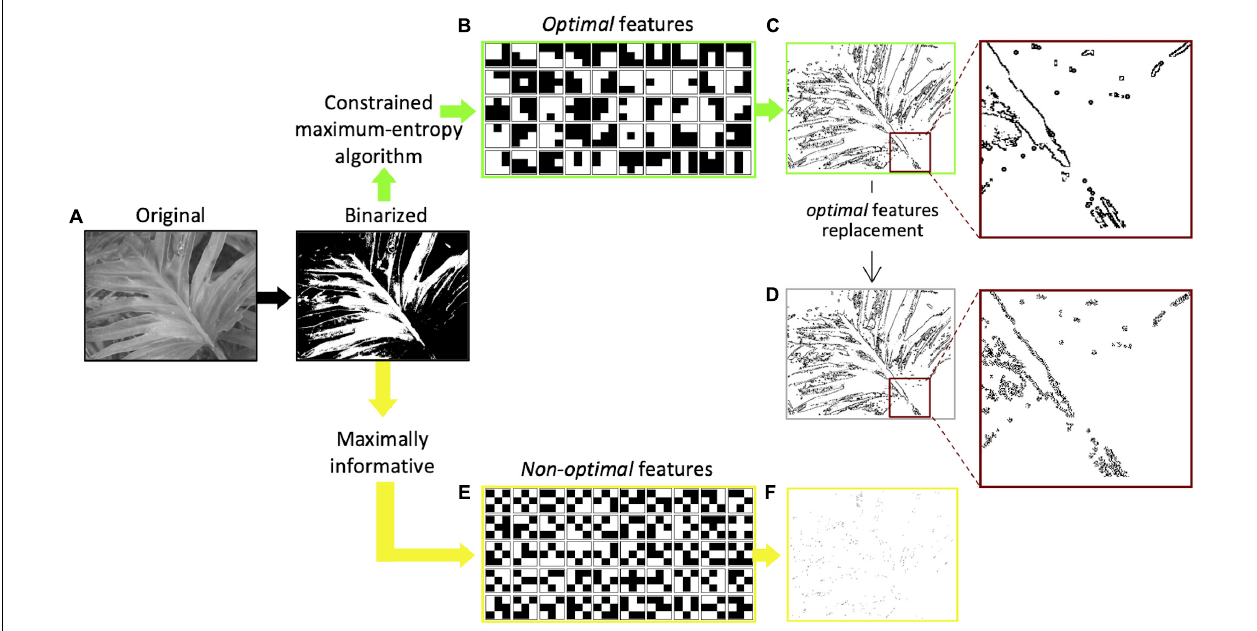
FIGURE 1 | Extraction of optimal and non-optimal features and examples of sketches. (A) Original versions of natural images (Olmos and Kingdom, 2004) were first digitized into black and white. (B) Set of 50 3 × 3-pixels optimal features extracted by applying to black and white images the constrained maximum entropy model (Del Viva et al., 2013). (C) Sketch obtained by filtering the image with features in (B) . All the optimal features are positioned along image contours, as shown in the inset. (D) Sketch obtained by replacing in (C) the optimal features with non-optimal features (Del Viva et al., 2016). The spatial structure of the features along the contours does not correspond to the orientation of the contour, as shown in the inset. (E) A set of 50 3 × 3-pixels non-optimal features with the lowest probability in the statistical distribution of all possible 3 × 3-pixel black and white features. (F) Sketch obtained by filtering the digitized image with the 50 features in (E)